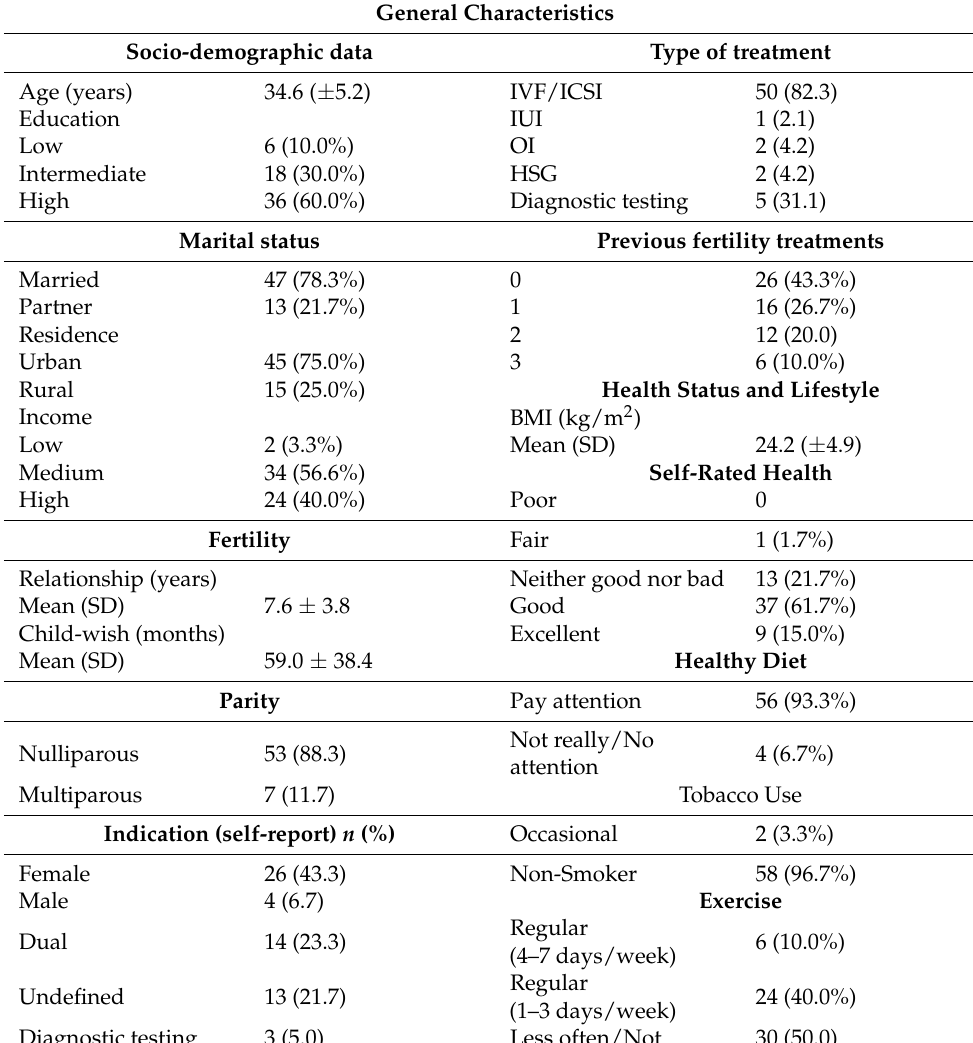
Table 1. General characteristics of the sample ( n =